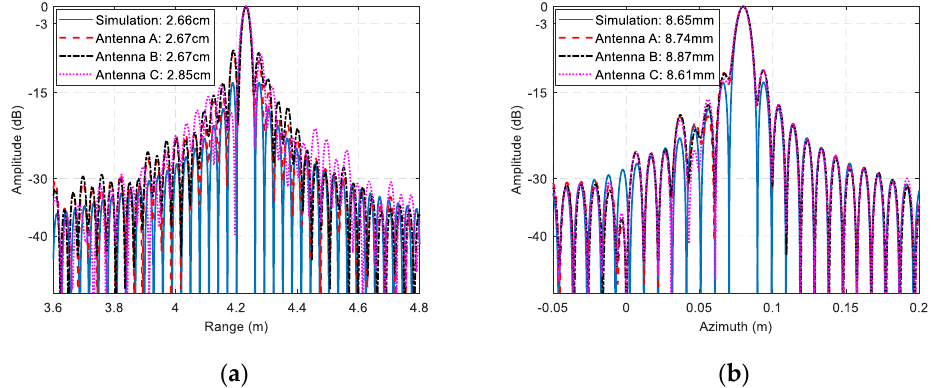
Figure 8. Comparison of range profiles and azimuth profiles between the right corner reflector and an ideal point target. ( a ) Range profiles; ( b ) Azimuth profiles.